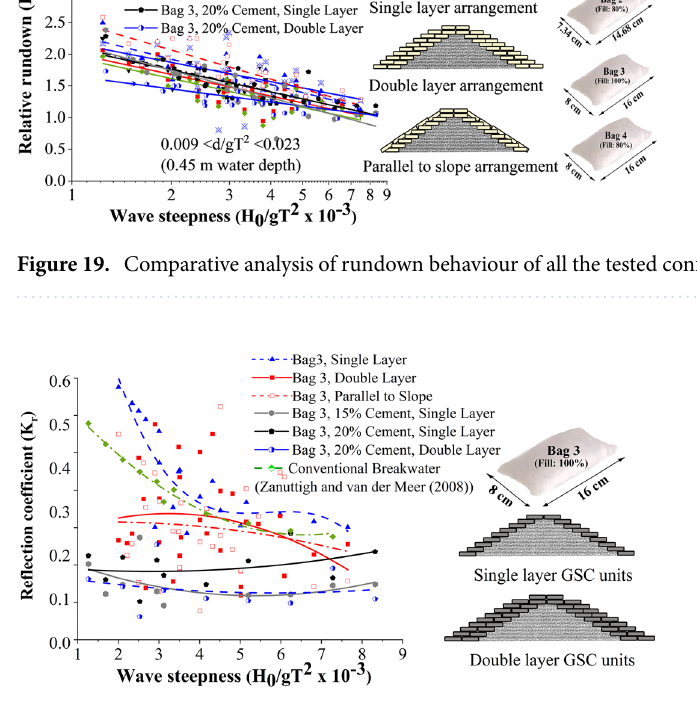
Figure 20. Reflection